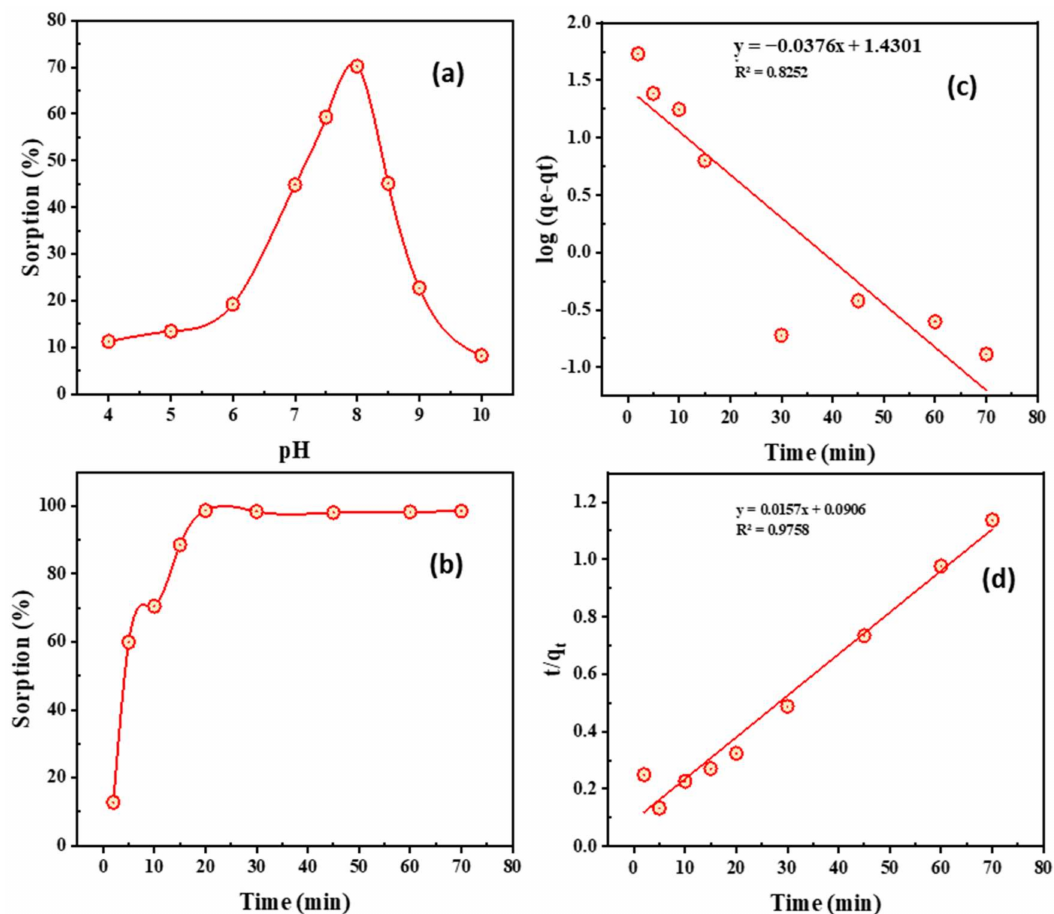
Figure 6. ( a ) impact of pH upon Co 2+ adsorption (20 mL of 250 mg/L Co 2+ , 10 min, 0.1 g of PTU- MSA, 25 ◦ C); ( b ) Impact of contacting time upon Co 2+ adsorption (20 mL of 250 mg/L Co 2+ , pH 8.0, 0.08 g of PTU-MSA, 25 ◦ C); ( c ) 1st-order kinetic plot; ( d ) 2nd-order kinetic plot of PTU-MSA’s Co 2+ adsorption (20 mL of 250 mg/L Co 2+ , pH 8.0, 0.08 g of PTU-MSA, 25 ◦